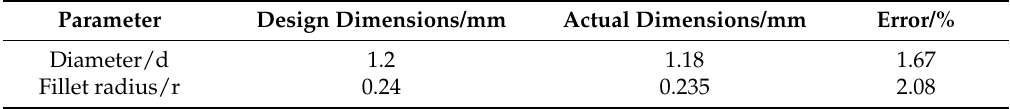
Table 1. The design dimensions and actual dimensions of the micro-die.